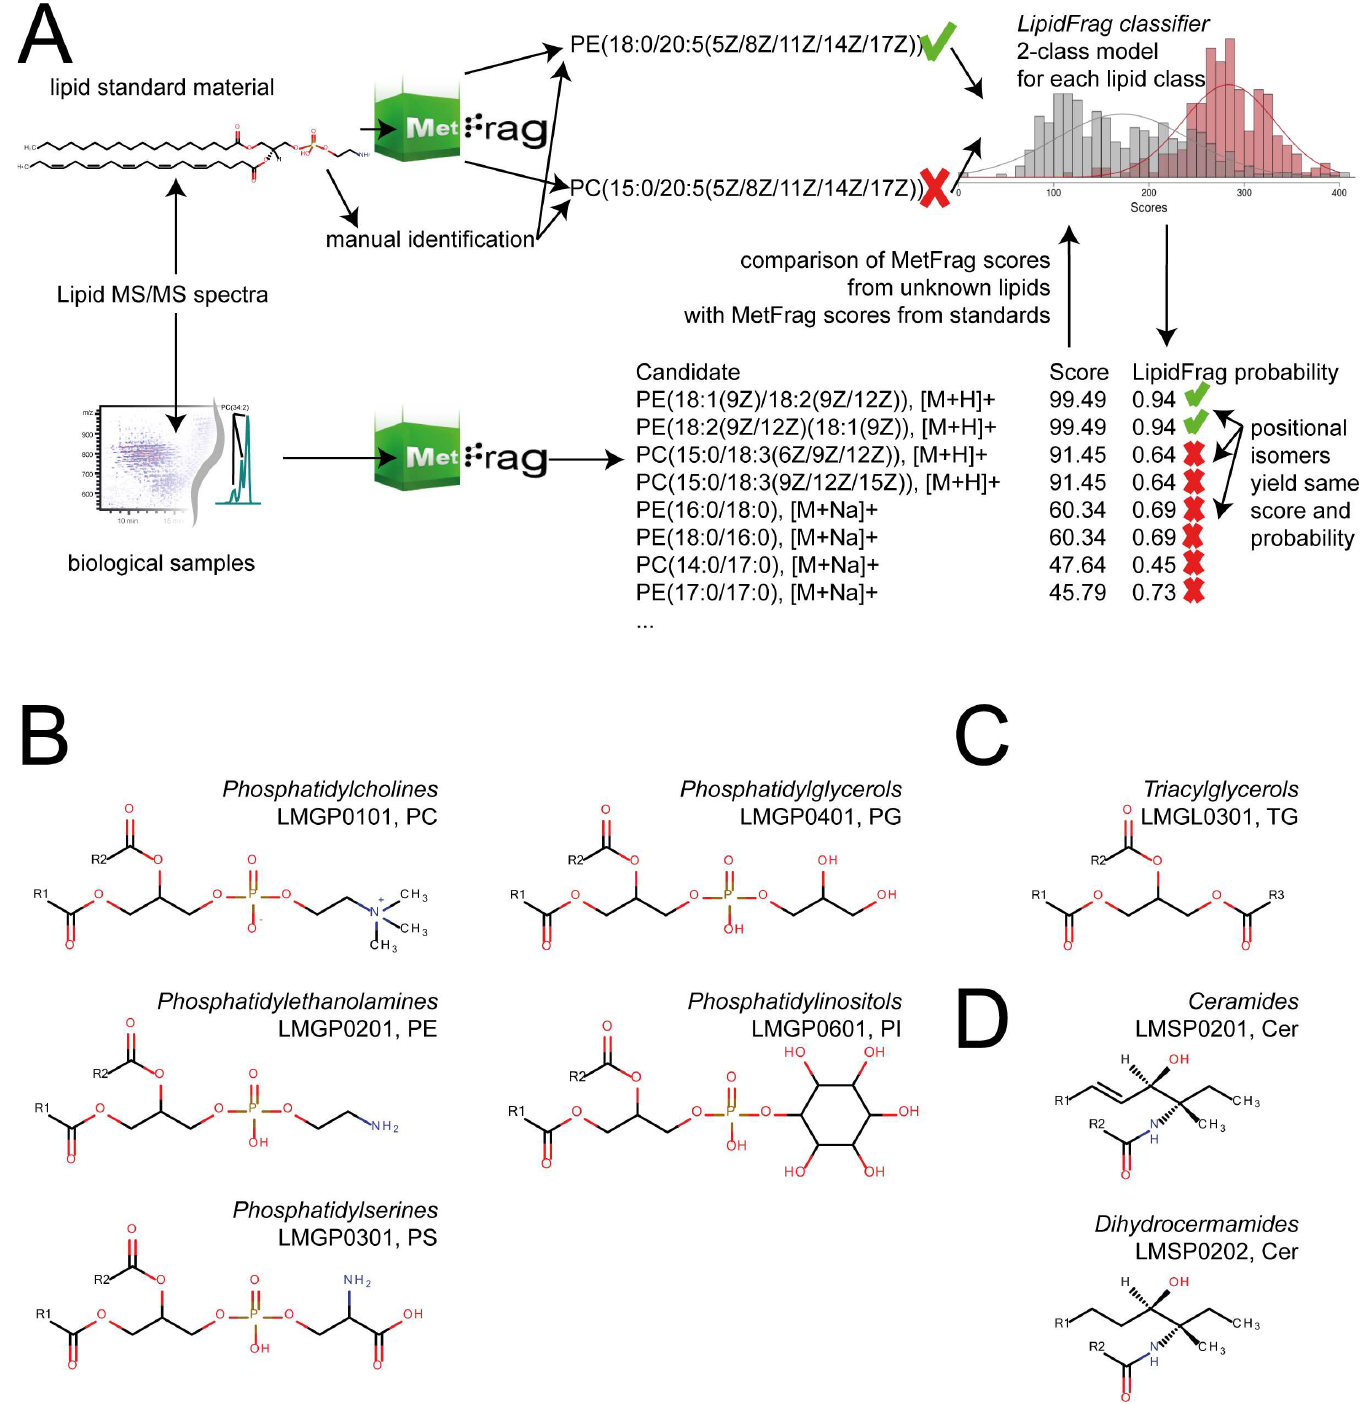
Fig 1. LipidFrag workflow and related lipid sub-classes. (A) Schematic drawingof LipidFragworkflow. MS/MS spectra from known lipids derived from lipid standardmaterialsand from unknownlipidsare subjectedto MetFrag in silico fragmentation, wherebyall possibleprecursor structures are taken into consideration.Duringtrainingphase true positive identity and decoy candidates are used to calculatea 2-class classifier by which reliableresults from unknownlipids can be identified. (B) Structures of detected phospholipid classes, phosphatidylethanolamines (PE, LMGP0201), phosphatidylcholines (PC, LMGP0101), phosphatidylglycerols (PG, LMGP0401), phosphatidylserines(PS, LMGP0301) and phosphatidylinositols(PI, LMGP0601) (C) Structure of triacylglycerols (TG, LMGL0301) (D) Structure of ceramides (Cer, LMSP0201) and dihydroceramides (Cer, LMSP0202).